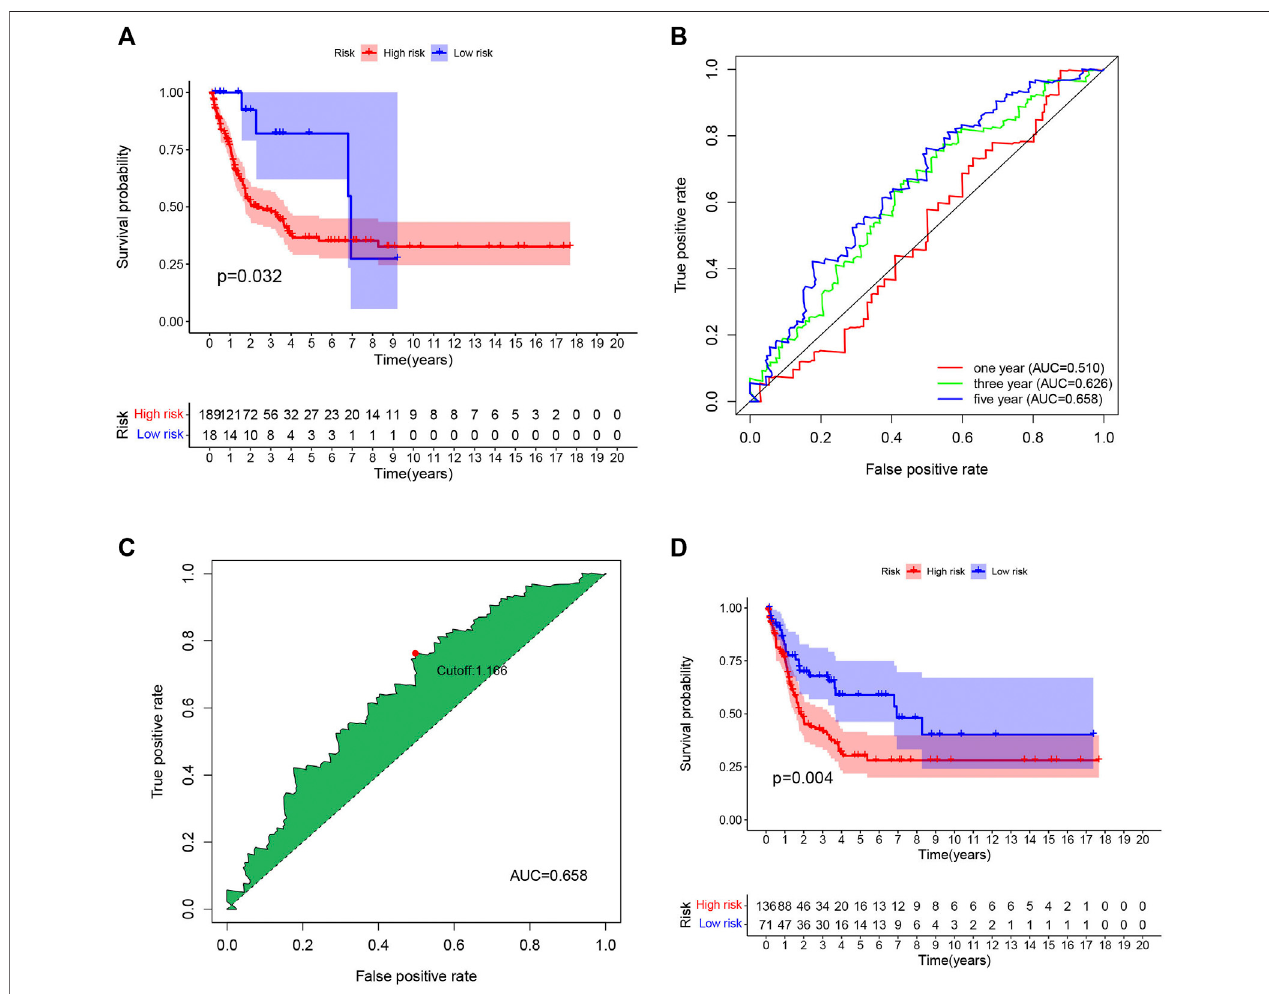
FIGURE 5 | External validation of the risk signature. (A) The same cutoff value as TCGA was used to verify in GEO database. (B) Receiver operating characteristic (ROC) curves for 1-,3-,5-year prognosis in GEO database. (C) 5-year was chosen to calculated the brst cutoff value in GEO database. (D) The Kaplan – Meier curves of melanoma patients at the high group and low-risk group in GEO cohort.